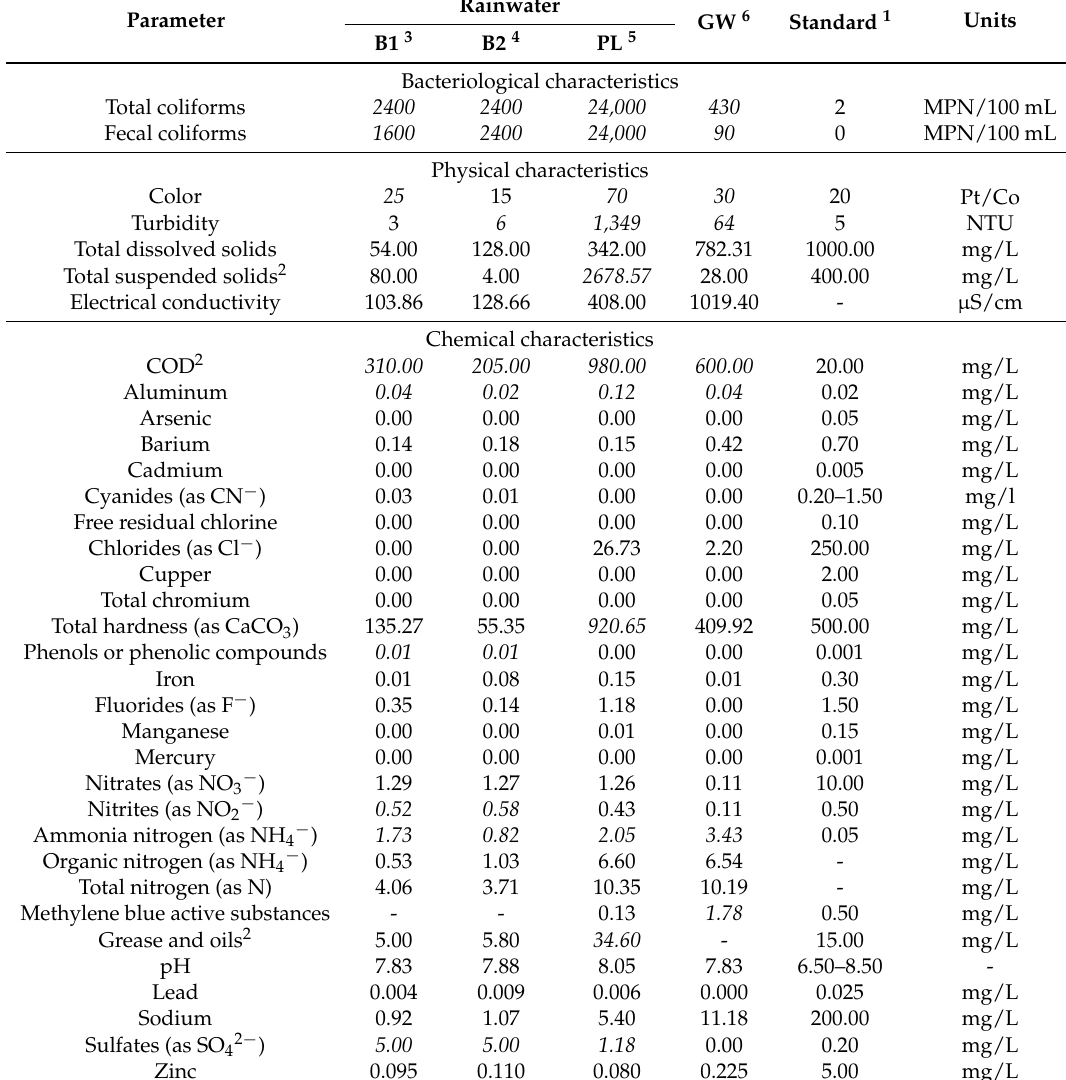
Table 3. Characteristics of rainwater and